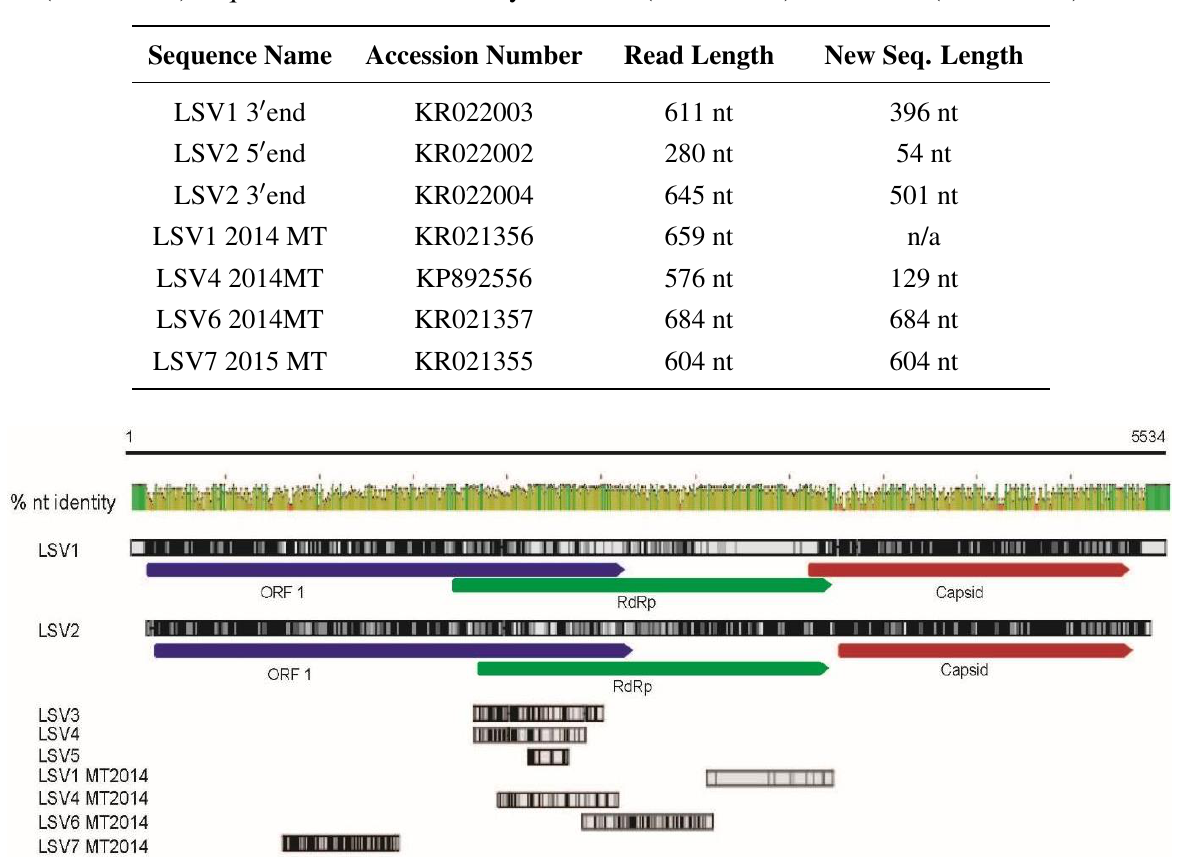
Table 1. New Lake Sinai virus sequences. The genomes of honey bee infecting viruses, LSV1 (HQ871931, 5508 nt) and LSV2 (5355 nt, HQ888865) were extended by sequencing 5’ and 3’ RACE products generated from RNA isolated from LSV-infected honey bees and semi-purified virus preparations. Sequencing LSVs also resulted additional LSV4